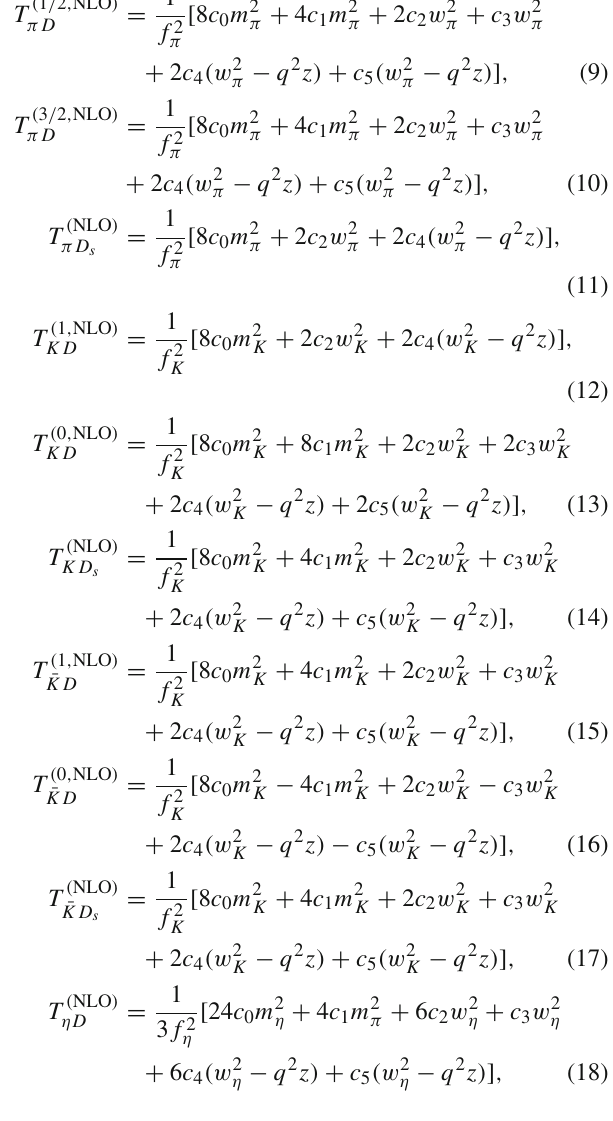
( 2 ) ( 3 ) and L , H φ H φ